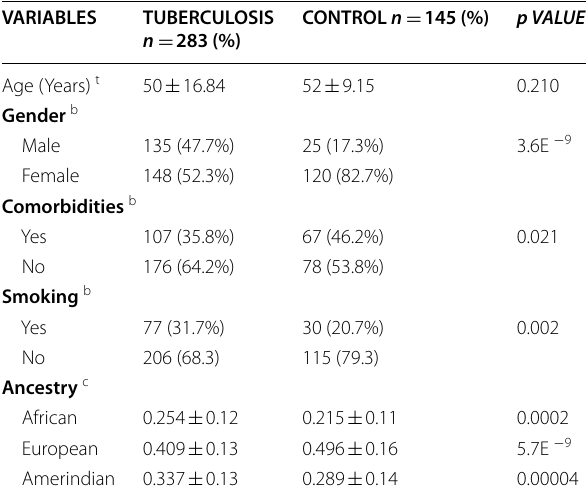
Table 1 Demographic and clinical characteristics of individuals with tuberculosis and control